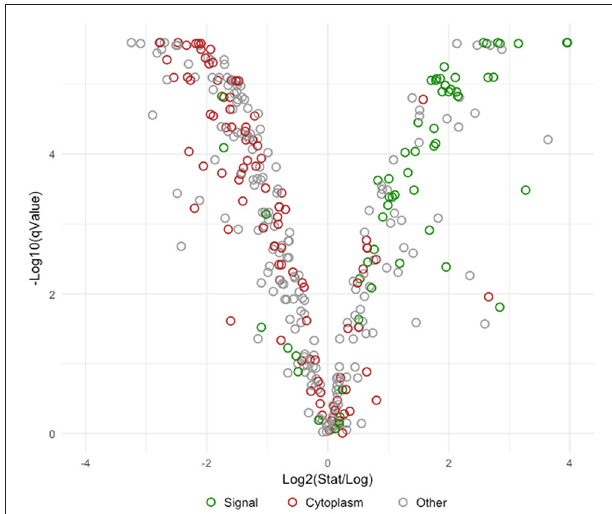
FIGURE 4 | Volcano plot comparing Log2 fold change to -Log10 statistical significance. Visually depicts the overall change in the early stationary phase S-layer associated proteome in comparison to logarithmic phase. Proteins possessing signal peptides are colored in green, those predicted to be cytoplasmic are colored red, and remaining proteins are colored